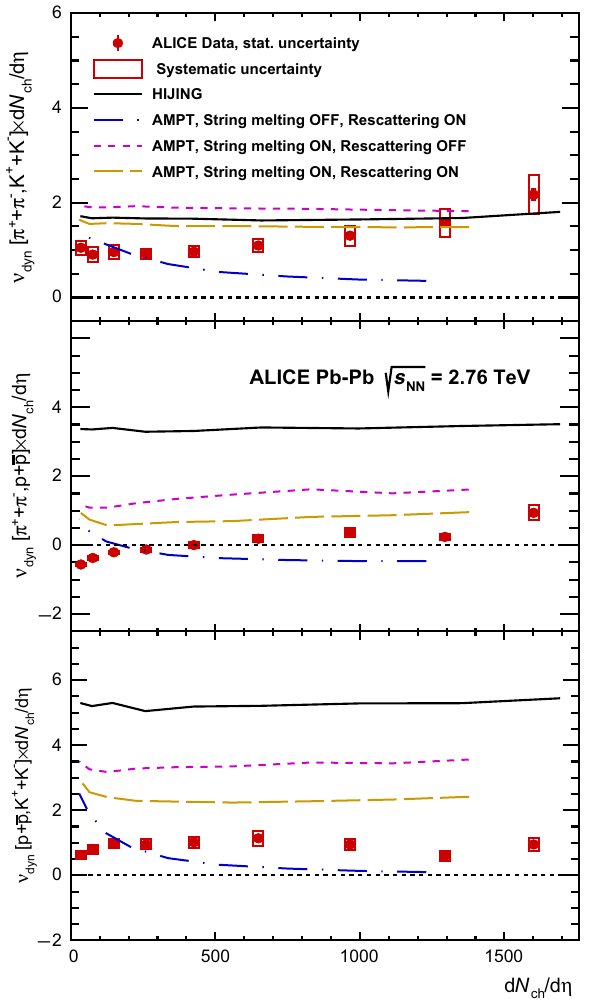
Fig. 3 Results for ν dyn [ π, K ] , ν dyn [ π, p ] and ν dyn [ p , K ] scaled by the charged-particle density d N ch / d η . The ALICE data are shown by red markers while the coloured lines indicate the HIJING [22,23] and AMPT [25] model calculations. The data are shown as a function